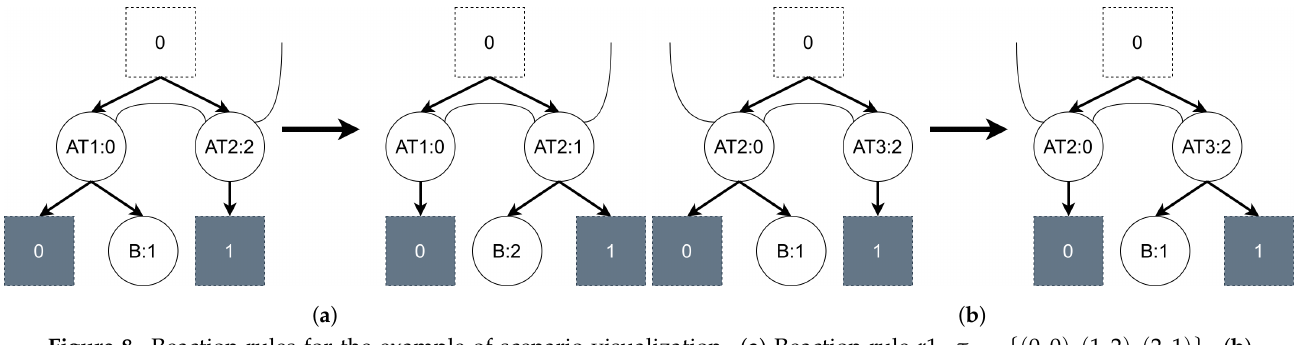
Figure 8. Reaction rules for the example of scenario visualization. ( a ) Reaction rule r 1. τ = Reaction rule r 2. τ =